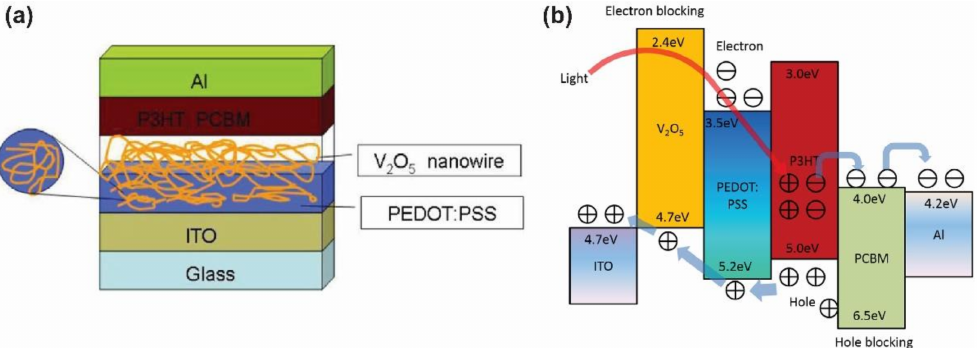
Figure 16. ( a ) Schematic representation of polymer photovoltaic cell based on PEDOT:PSS/V 2 O 5 HTL and ( b ) energy level alignment for the cell components. Adapted with permission from [308]. Copyright 2016,